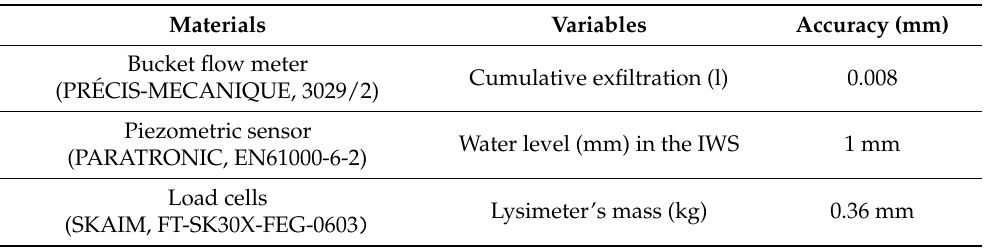
Table 1. Details of materials used for measurement on each lysimeter (the accuracy is expressed in equivalent mm of water in a